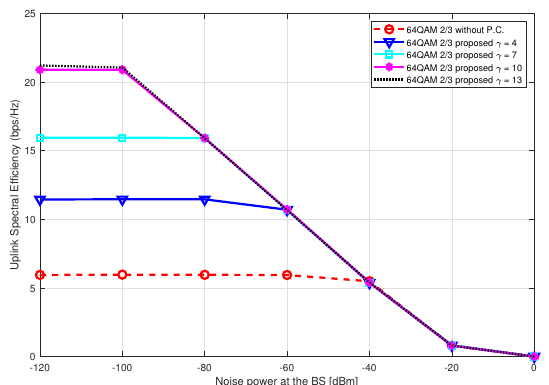
Figure 12. Spectral efficiency for 64QAM-2/3 versus noise power with different values of γ .